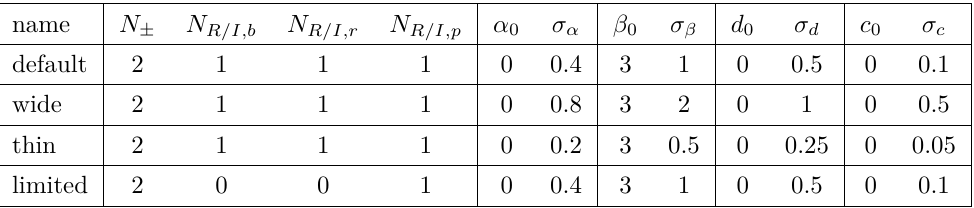
Table 3 . The configurations of the models used to determine the continuum PDF. The model is modified to test the stability of the method.